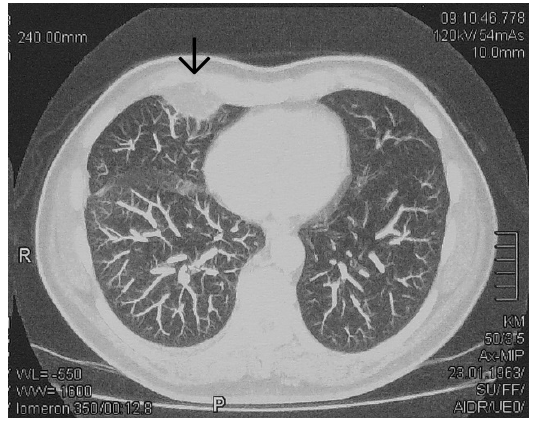
Figure 2. Computed tomography pulmonary angiogram (CTPA) showing an area of subpleural PI (arrow) in the right lower